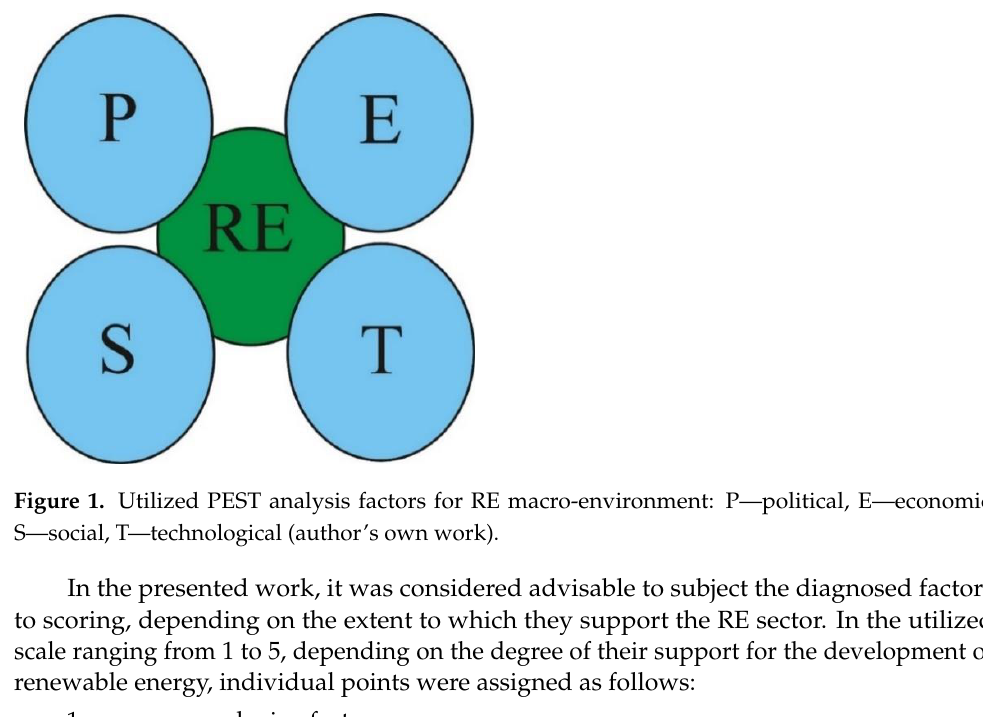
Table 1. The political environment of RE sources in the Pomerania Voivodeship (author’s own work).